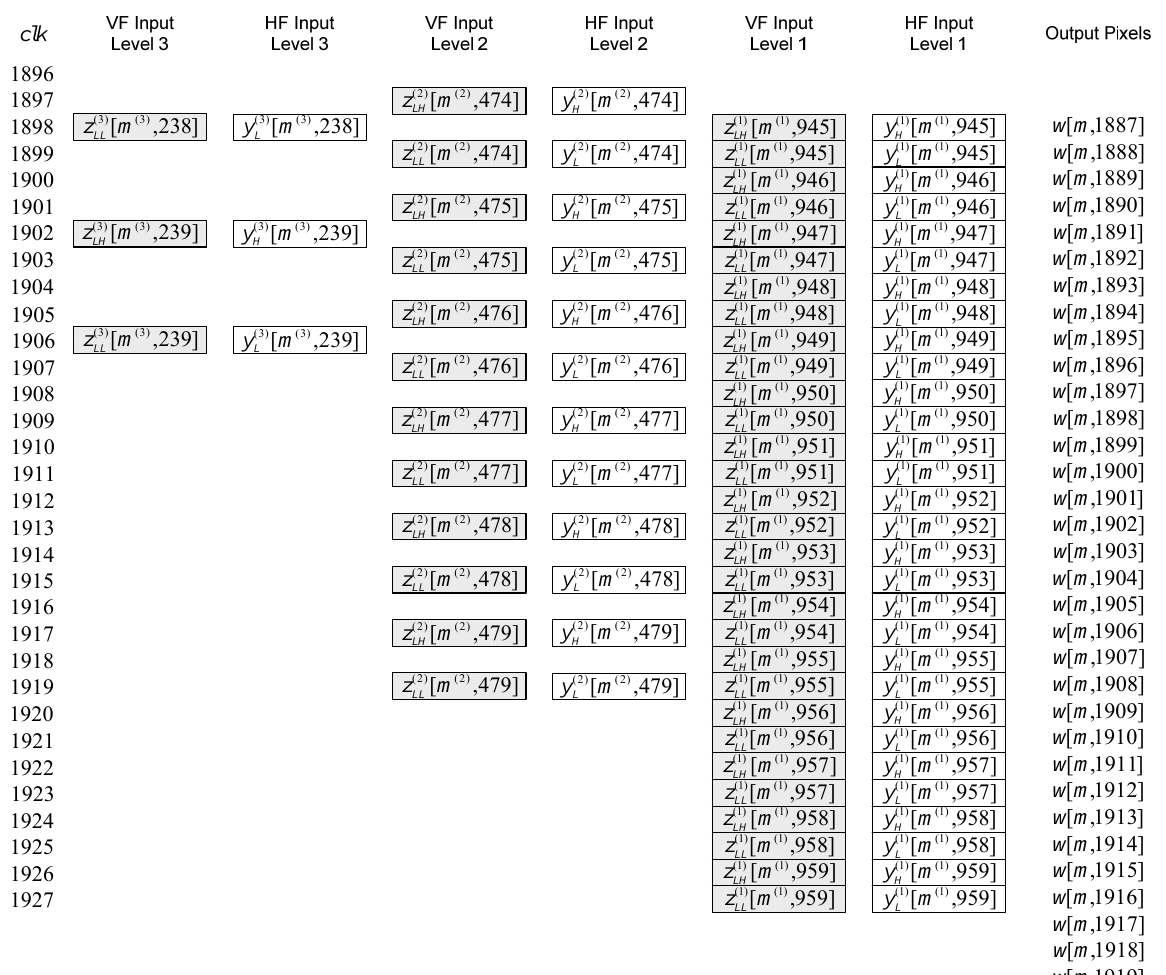
Figure 13. The time diagram of the 2 ‐ D inverse DWT 5/3 filtering at the beginning of even lines.